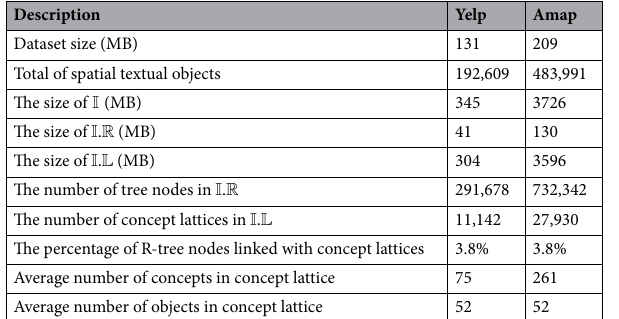
Table 3. The details of RCL-tree index